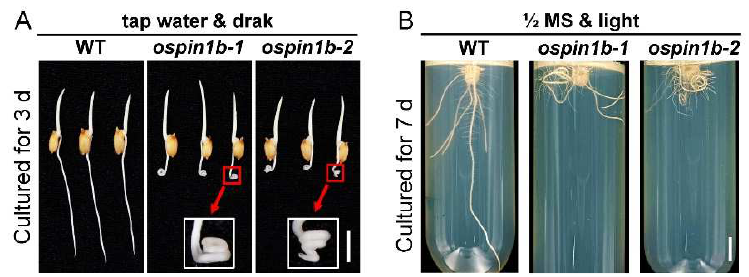
Figure 8. Mutation of OsPIN1b resulted in root agravitropism in ospin1b mutants. ( A ) Rice plants were cultured for 3 days with tap water in the dark. ( B ) Rice plants were cultured for 7 days with half-strength Murashige and Skoog (MS)-agar solid medium in light. Bar = 1 cm.